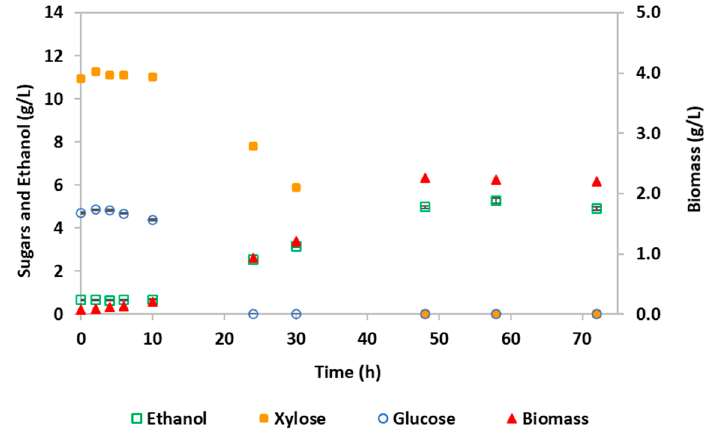
Figure 1. Time course of S. stipitis fermentation using the hydrolysate detoxified by membrane nanofiltration: glucose, xylose, bioethanol and biomass concentrations (50 mL, 150 rpm, initial pH 5.5 and 30 °C).